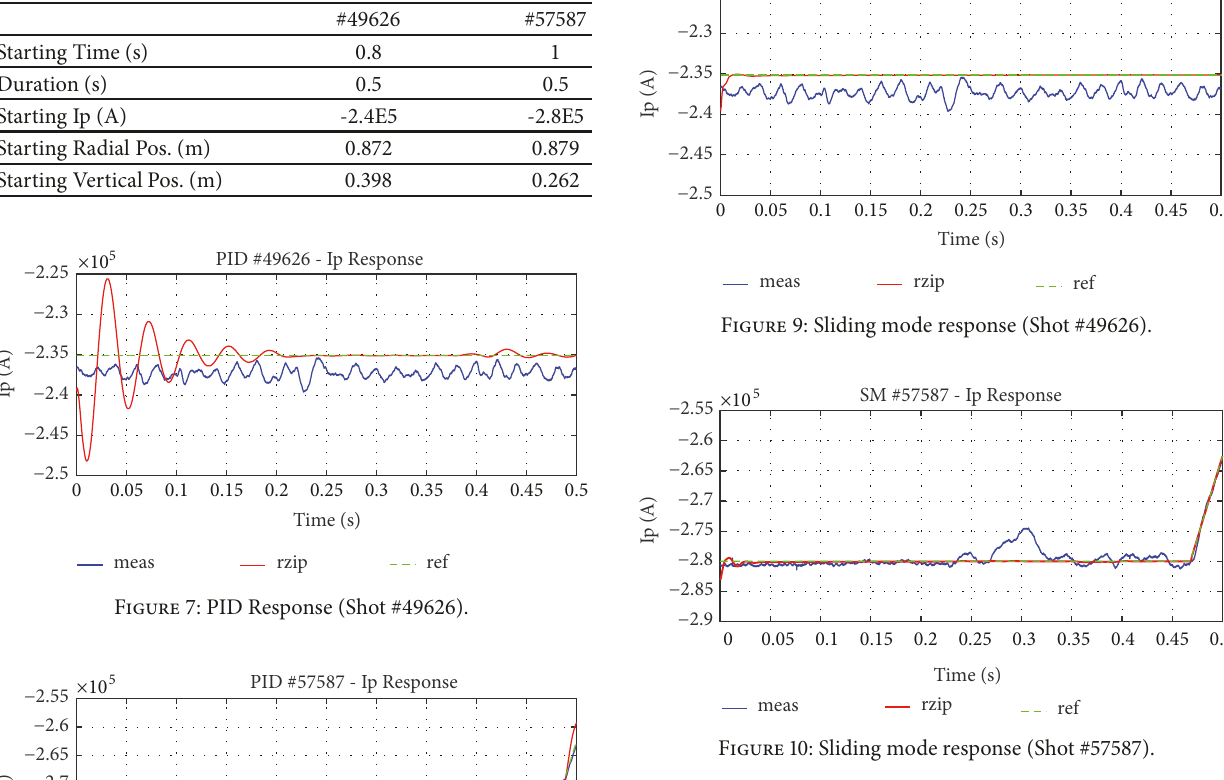
Table 2: Simulated shots.